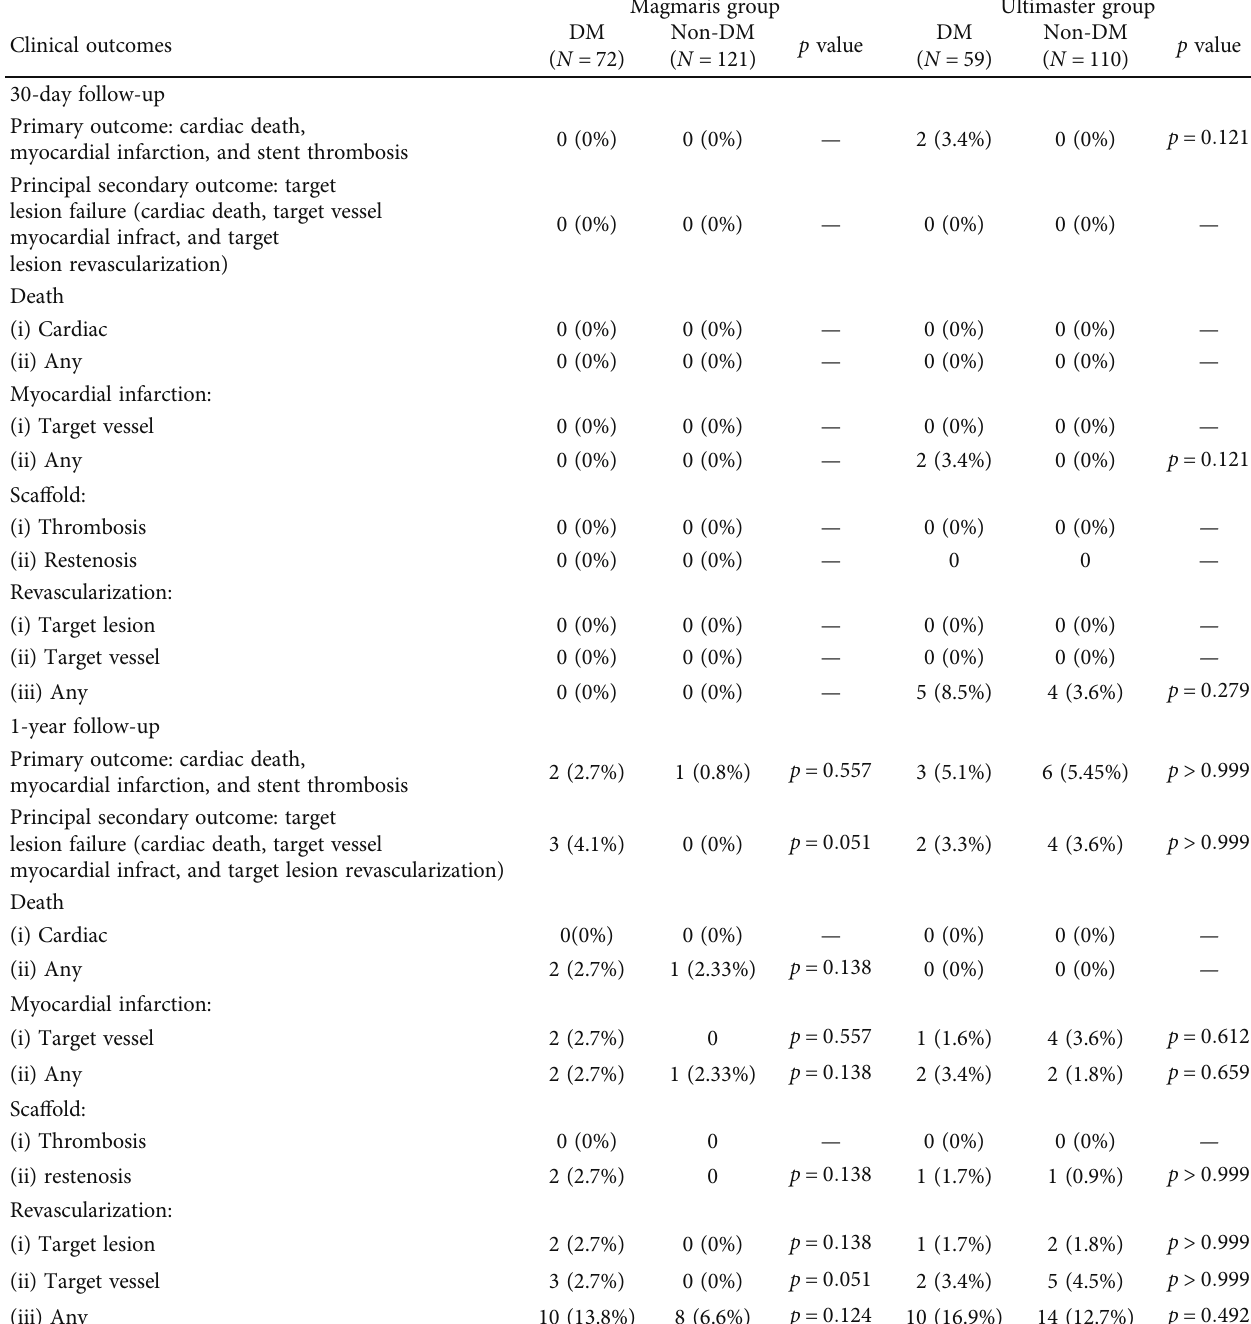
Table 3: Clinical outcomes in both study arms. Magmaris group Ultimaster